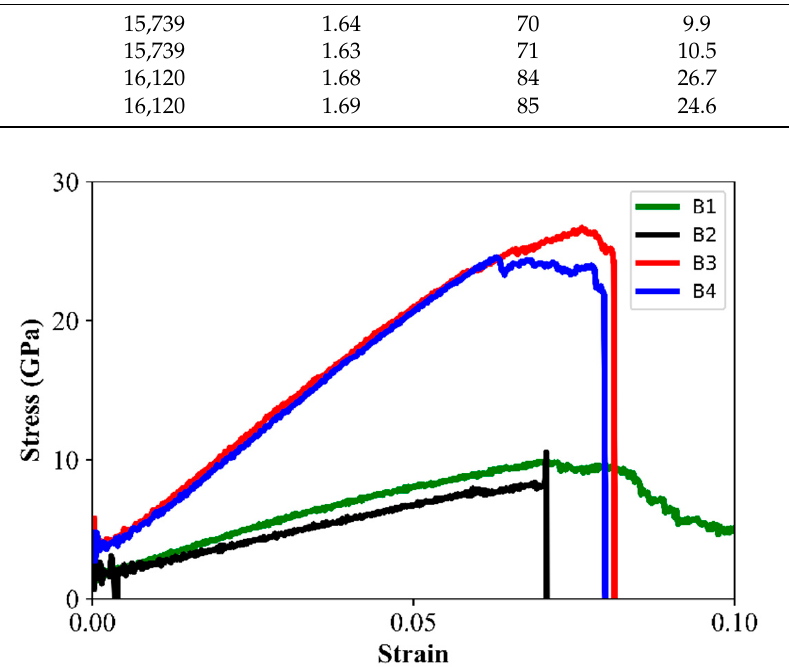
Figure 3. Stress-strain curves predicted in axial deformation of simulated carbon fiber structures with a maximum value of Young’s modulus equal to 277.0 GPa and tensile strength of 26.7 GPa for the B3